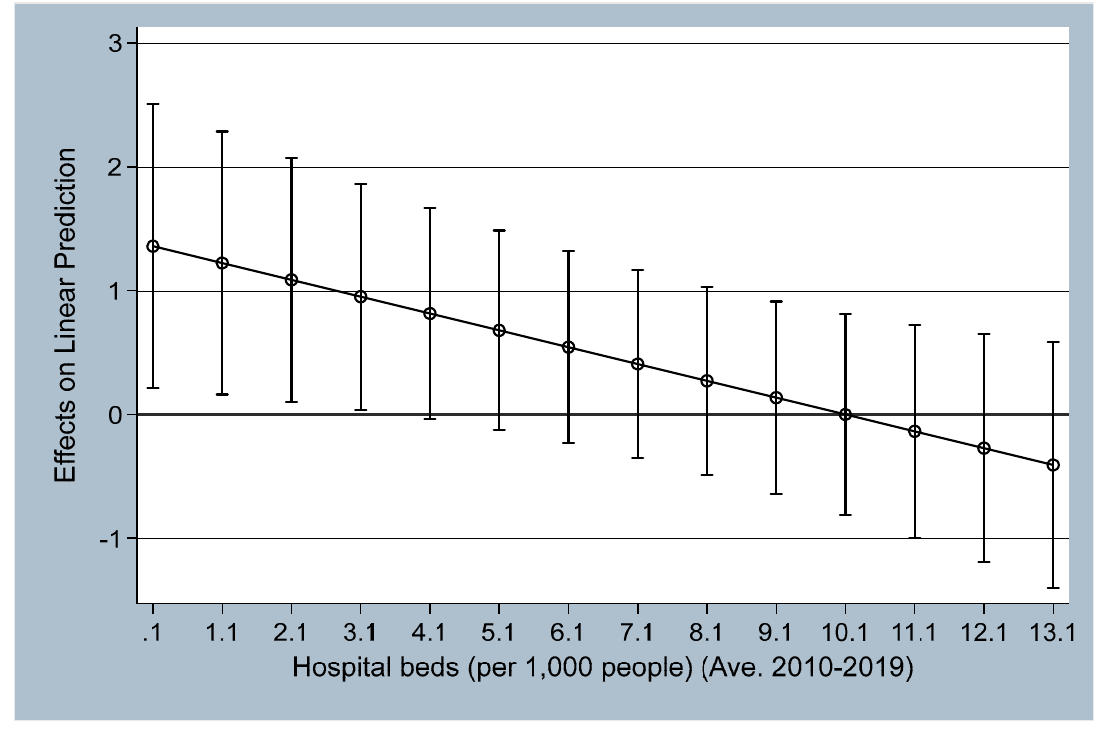
Figure 2. Marginal effect of elderly population on COVID ‐ 19 mortality with 95% confidence intervals.